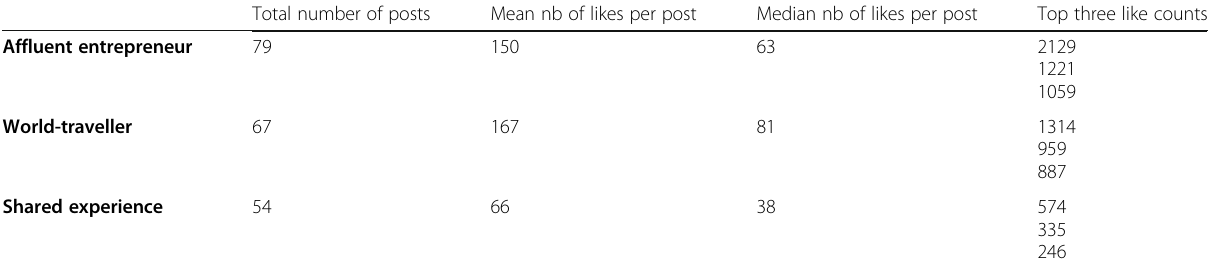
Table 3 Table of number of total posts and engagement (as determined by number of likes) of the three